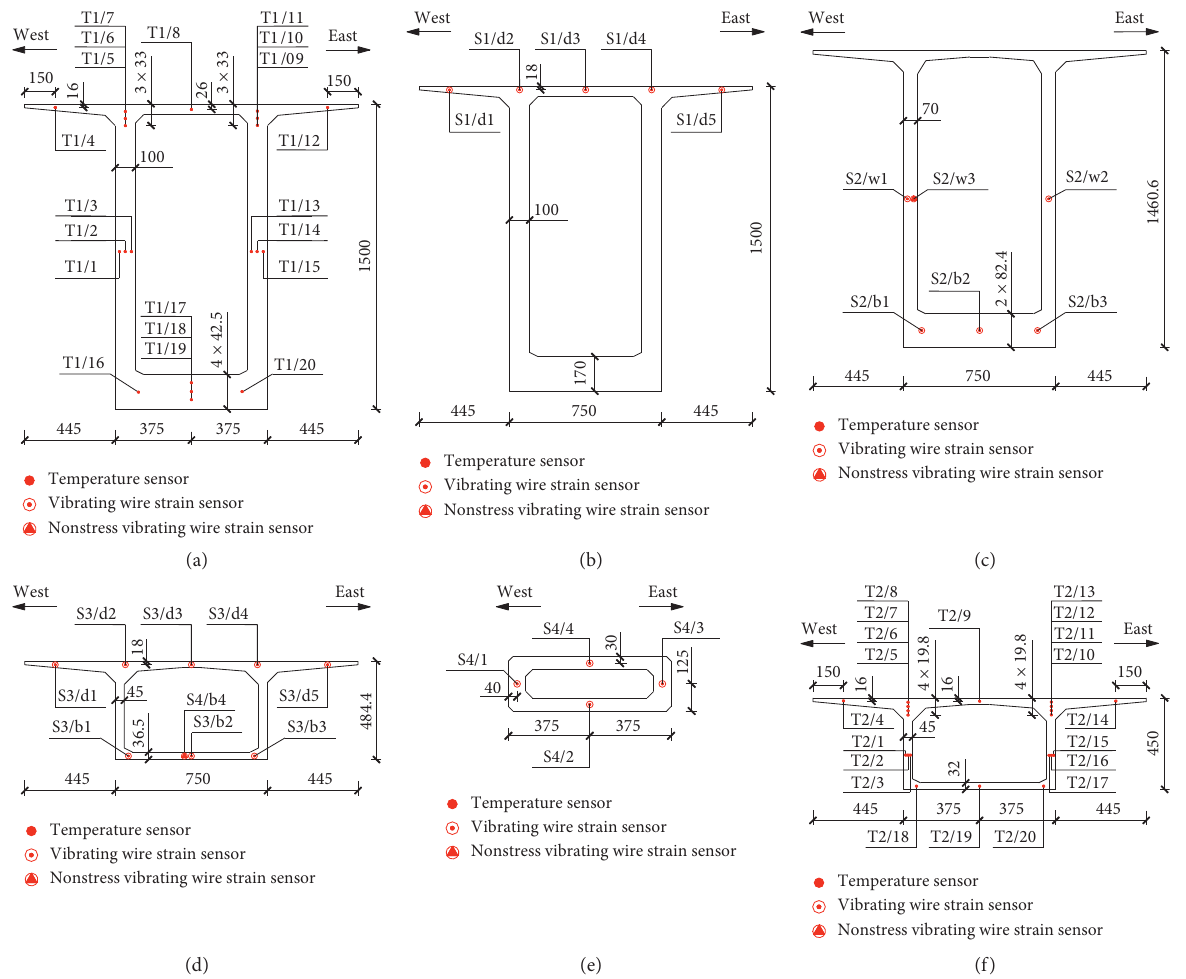
Figure 2: Characteristic section dimensions and layout of the sensors. (a) Section T1. (b) Section S1. (c) Section S2. (d) Section S3. (e) Section S4. (f) Section T2 (unit: